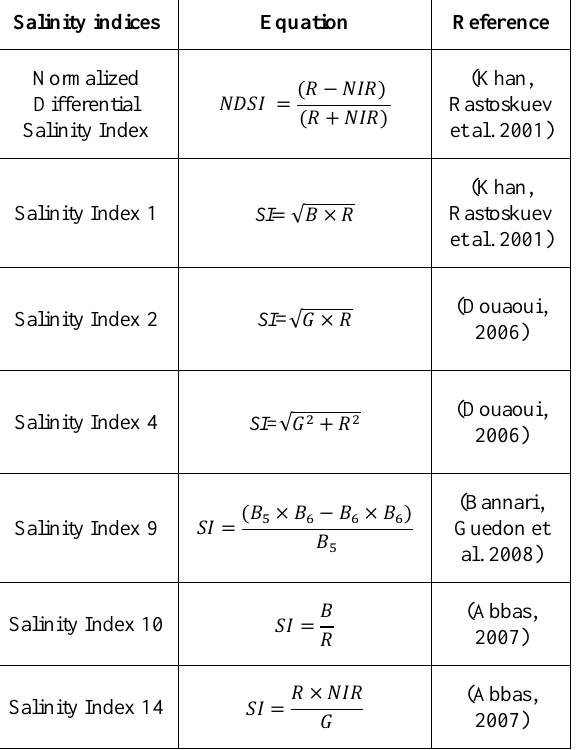
Table 2: The most common salinity indices used in this